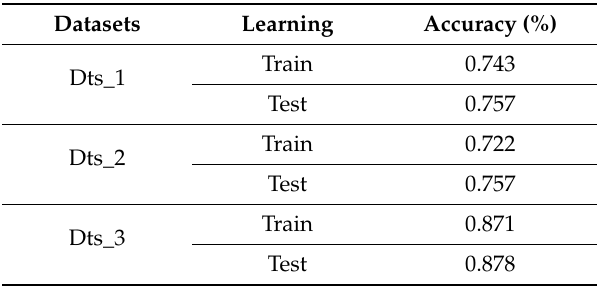
Table 18. Training and testing results for multi-class SVM.